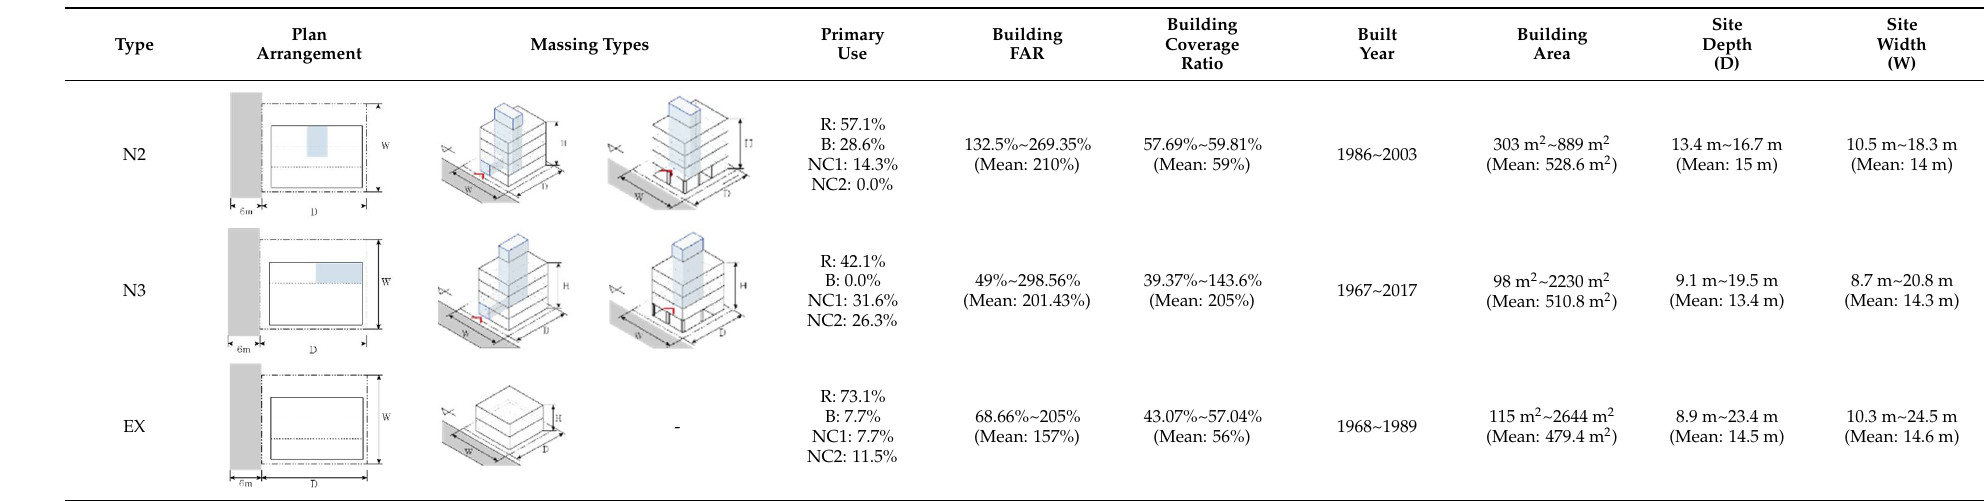
10 of 21 Table 2. Characteristics of massing types.